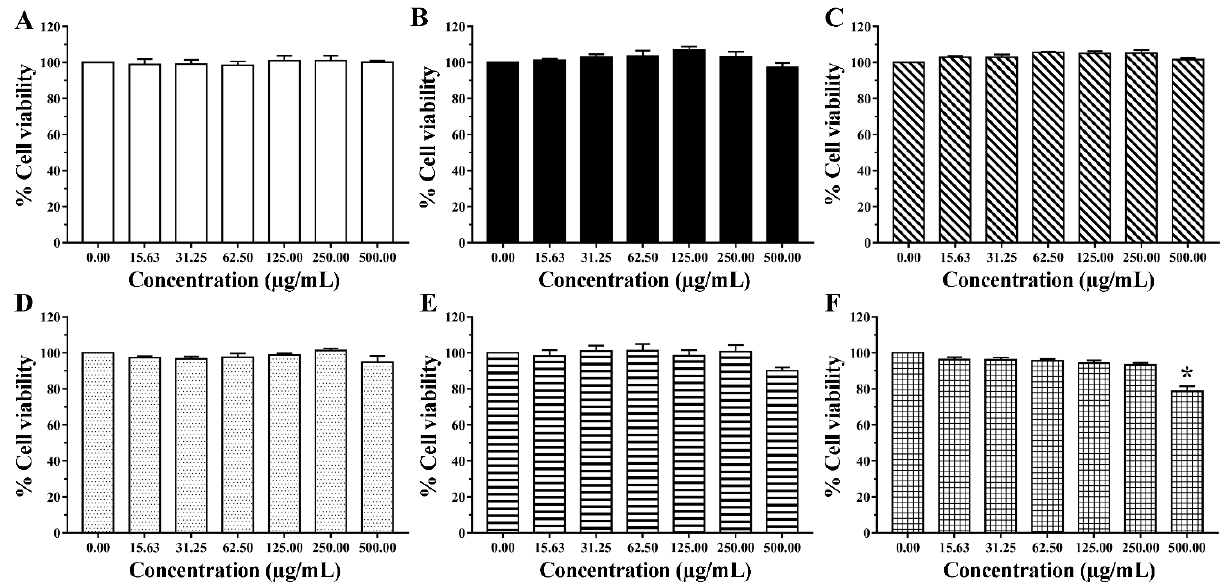
Figure 7. Dose-response curves of viability of PBMCs exposed to AGO in DMSO for ( A ) 1 h, ( B ) 3 h, ( C ) 6 h, ( D ) 12 h, ( E ) 24 h, and ( F ) 48 h. Data are presented as means ± SEM and were analyzed based on a one-way ANOVA followed by Tukey’s post-hoc test ( p < 0.05). Asterisk (*) indicates significant differences between concentrations of AGO.